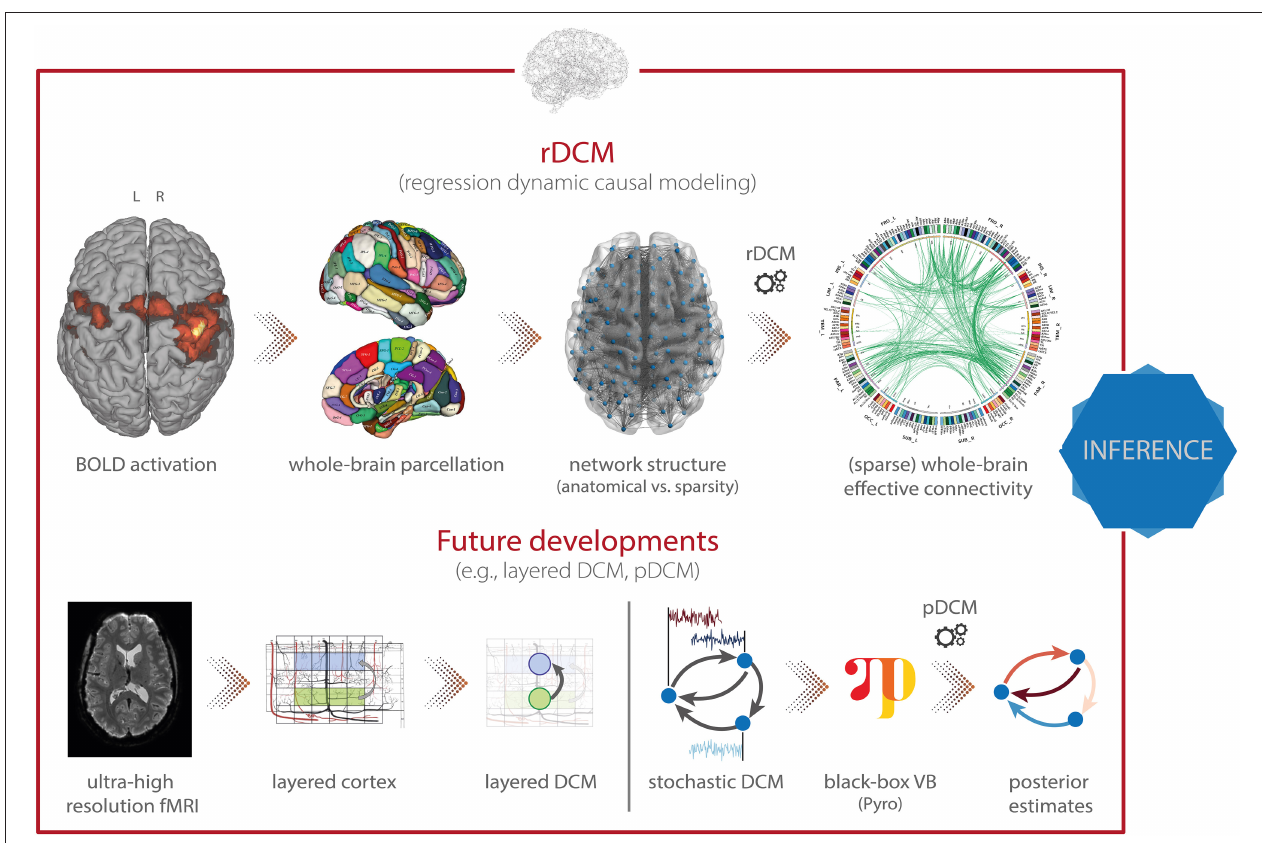
FIGURE 6 | TAPAS components that implement generative models of neuroimaging data (II). (Top) Regression dynamic causal modeling (rDCM) is a novel variant of DCM for fMRI that scales gracefully with the number of nodes and thus makes whole-brain effective connectivity analyses feasible. (Bottom) Layered DCM (l-DCM) and pDCM as future developments of DCM, representing tools that will be included in TAPAS in one of the next upcoming releases. Parts of figure reproduced with permission from Heinzle et al. (169), Copyright 2016 Elsevier, and (167), Copyright 2020